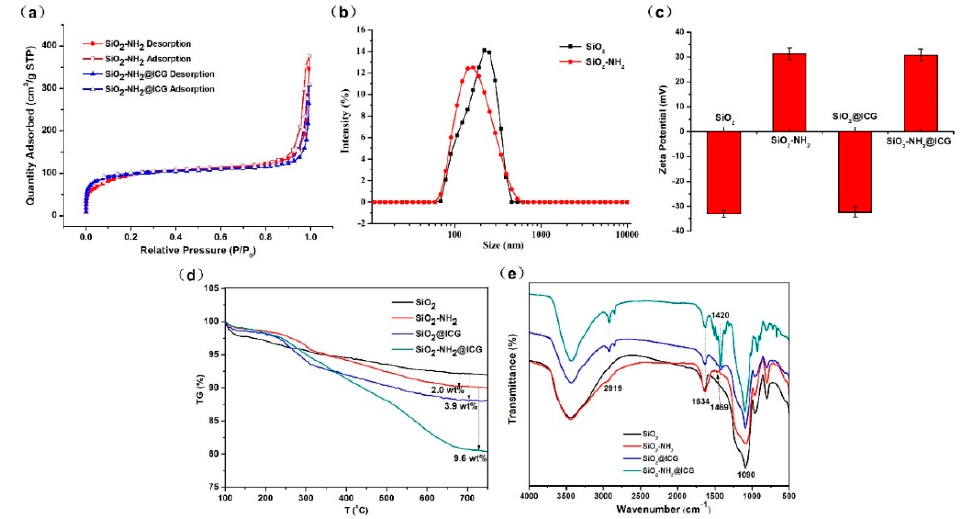
Figure 3. ( a ) N 2 adsorption/desorption isotherms of the SiO 2 -NH 2 and SiO 2 -NH 2 @ICG NPs; ( b ) DLS measurement of the size distribution of SiO 2 and SiO 2 -NH 2 NPs; ( c ) zeta potentials of SiO 2 , SiO 2 -NH 2 , SiO 2 @ICG and SiO 2 -NH 2 @ICG; ( d ) TG curves of SiO 2 , SiO 2 -NH 2 , SiO 2 @ICG and SiO 2 -NH 2 @ICG NPs; ( e ) Fourier-transform infrared (FTIR) spectra of SiO 2 , SiO 2 -NH 2 , SiO 2 @ICG and SiO 2 -NH 2 @ICG NPs.